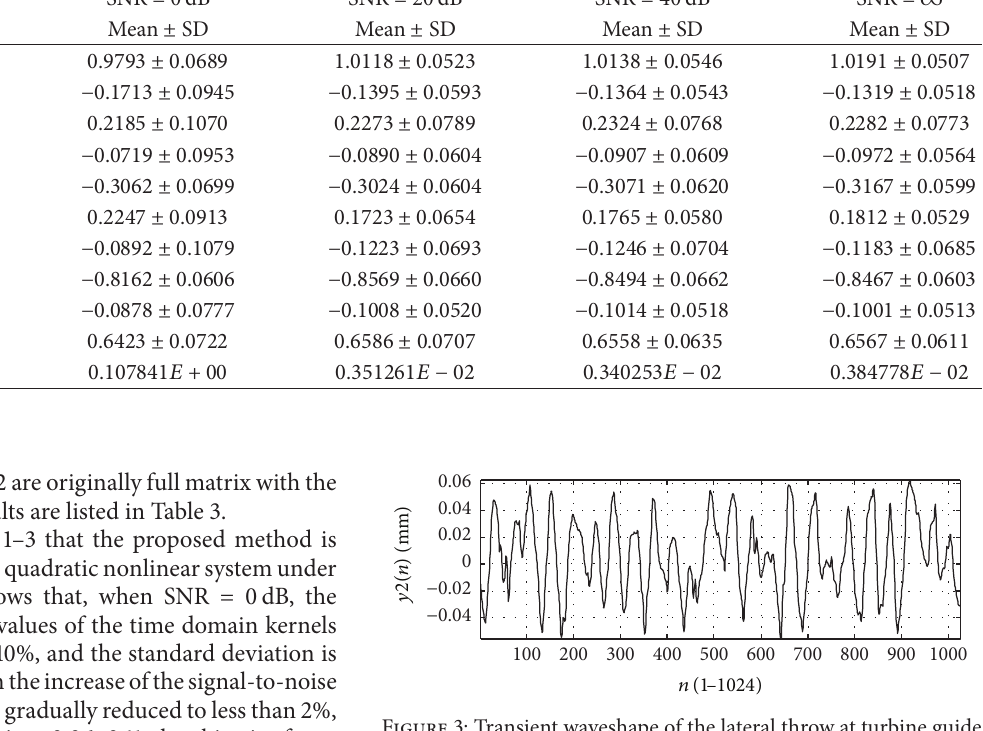
Figure 3: Transient waveshape of the lateral throw at turbine guide bearing